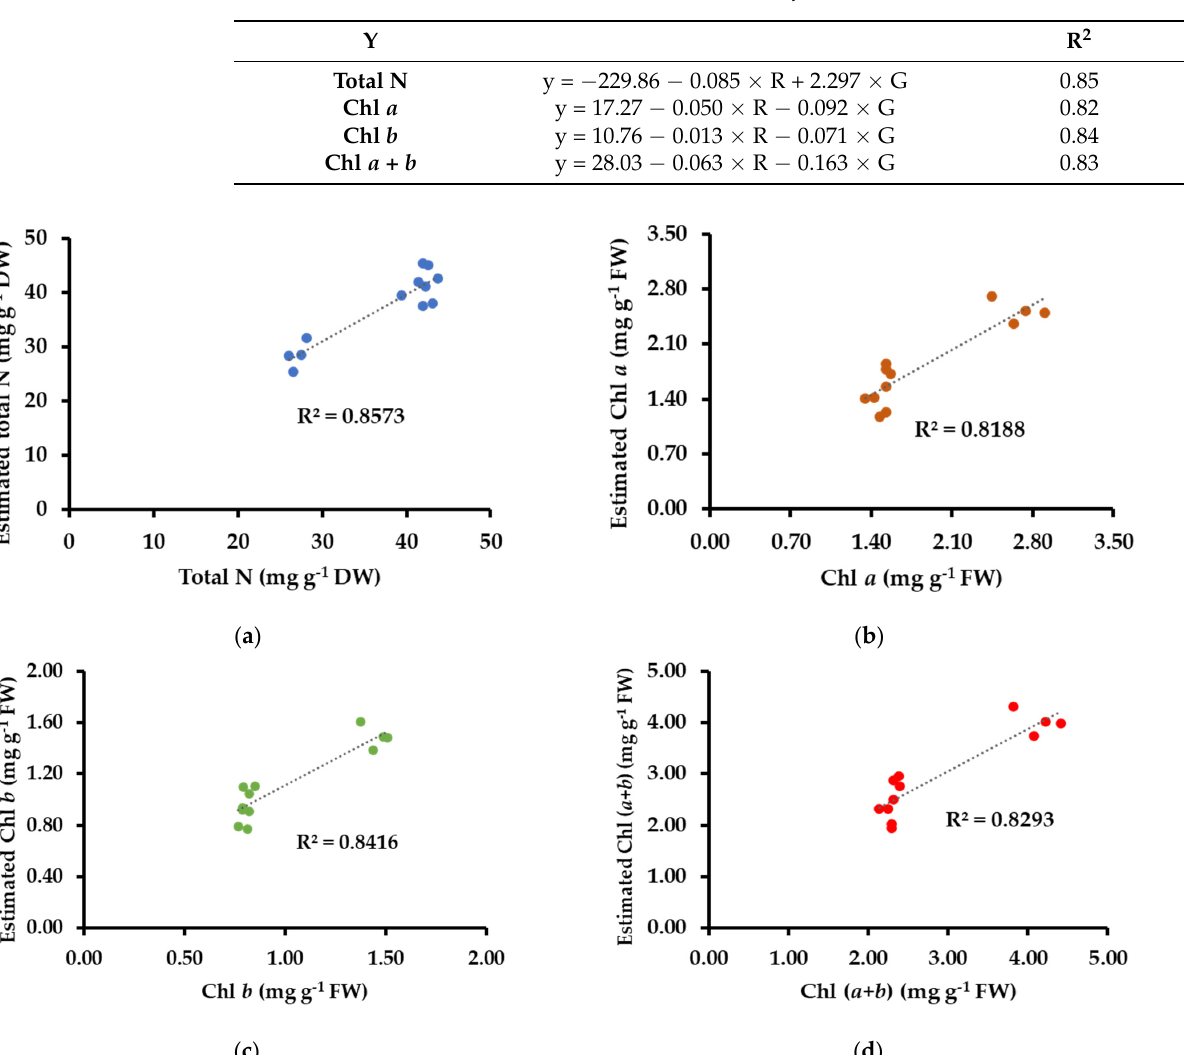
The values in bold correspond to the values higher than 0.60 at p < 0.05. Table 3. Equations and the coefficient of determination (R 2 ) for the linear regression value between total N, Chl a , b and a + b (Y), and R and G (X) in P. obtusifolia.